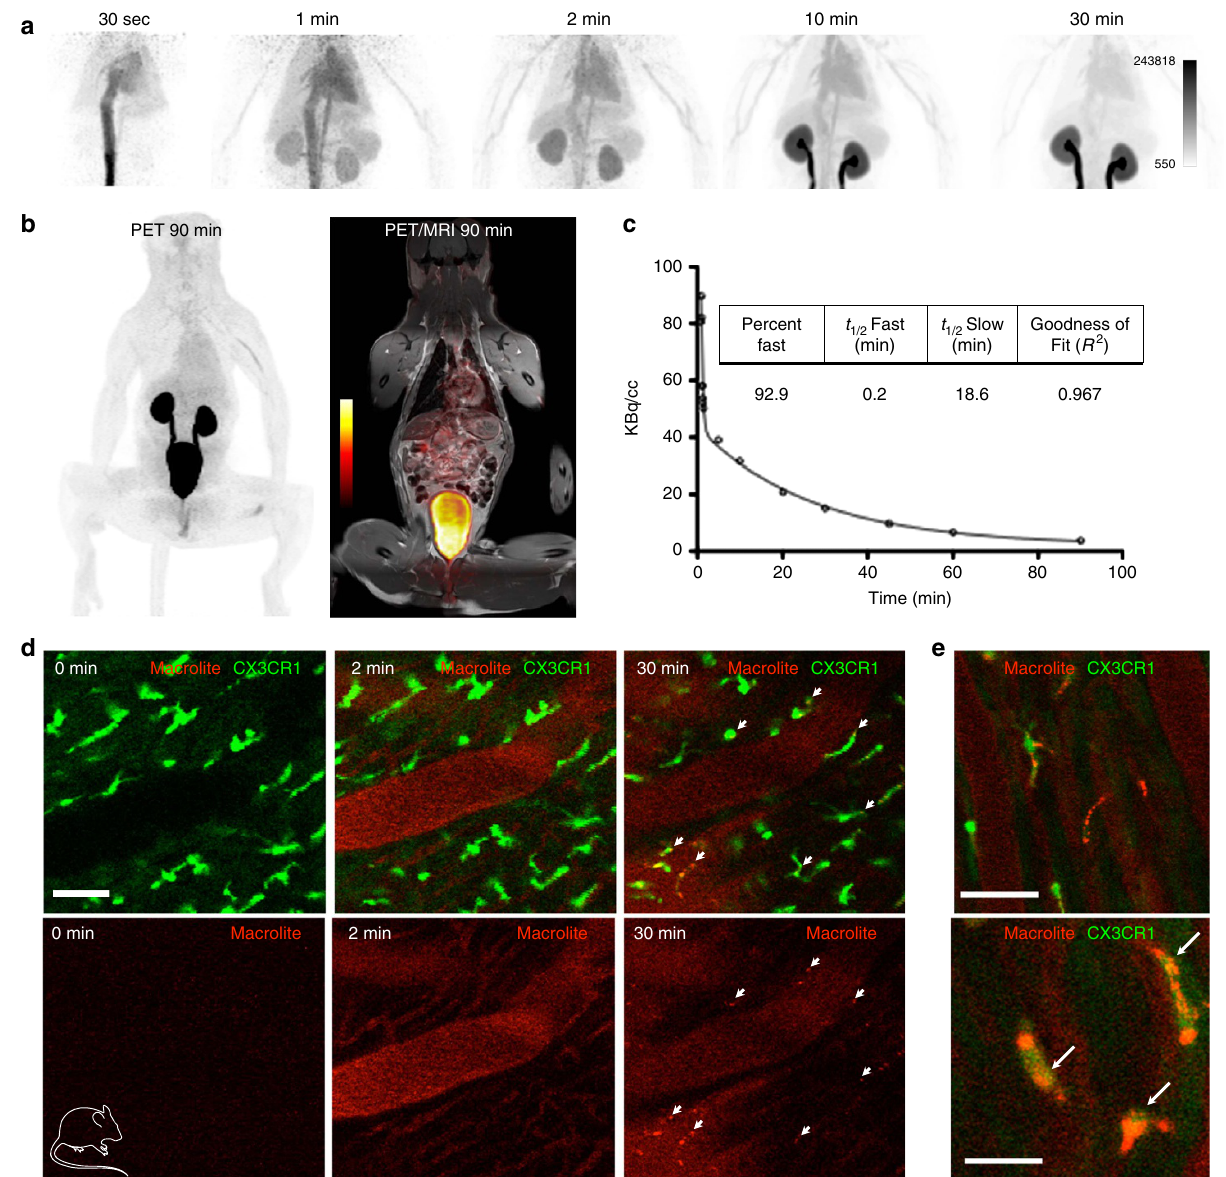
Figure 2 | Macroflor PET/MRI in non-human primate and rapid uptake into mouse cardiac macrophages. Macroflor is excreted rapidly via the kidneys and is taken up by cardiac macrophages. ( a ) PETmaximum intensity projection images from dynamic scan. A single primate experiment was carried out. ( b ) Full-body PET/MR images 90min into dynamic scan (Left: PET; Right: PET/MRI). ( c ) Macroflor time-activity curve derived from PET SUV data in non-human primate cardiac blood pool. ( d ) Intravital dynamic confocal microscopy of Macrolite uptake into cardiac macrophages carried out in a single Cx 3 cr 1 GFP/ þ reporter mouse. The upper panel shows green GFP signal indicating cardiac macrophages and red VT680 signal reporting on Macrolite presence. The 0min image was acquired before fluorescent probe injection into the tail vein. Intravascular signal is detected 2min later, while the 30min time point illustrates co-localized Macrolite and GFP þ macrophages. Scale bar, 50 m m. ( e ) Higher magnification images illustrate co-localization of Macrolite and macrophage signal. Scale bars, 50 m m (upper panel) and 25 m m. Mouse cartoon image is reproduced from the servier medical art image data bank of inflammation. During the resolution phase, macrophages assume less inflammatory phenotypes and promote tissue repair. counting (Fig. 5d) and autoradiography exposure (Fig. 5e) of excised mouse hearts. Flow cytometric evaluation of cardiac leukocytes showed significant enrichment in macrophages (Fig. 5f–h).